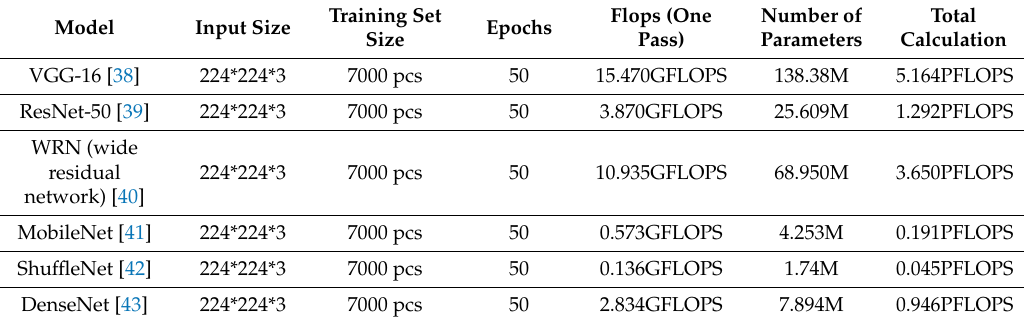
Table 3. Di ff erent model training and inference parameters.